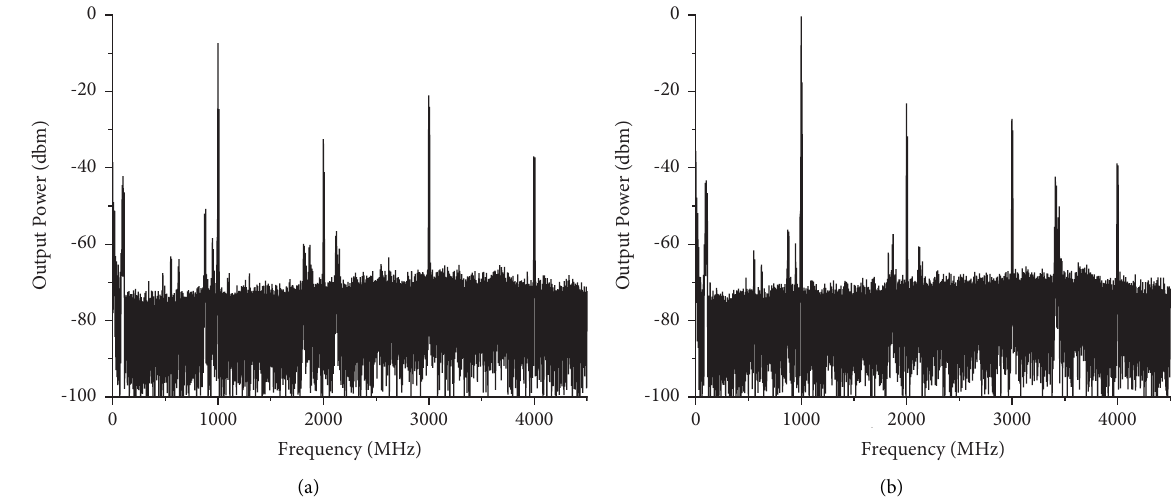
Figure 15: (a) Spectrum at the upper end of the SBD and (b) spectrum at the back end of the TL2.